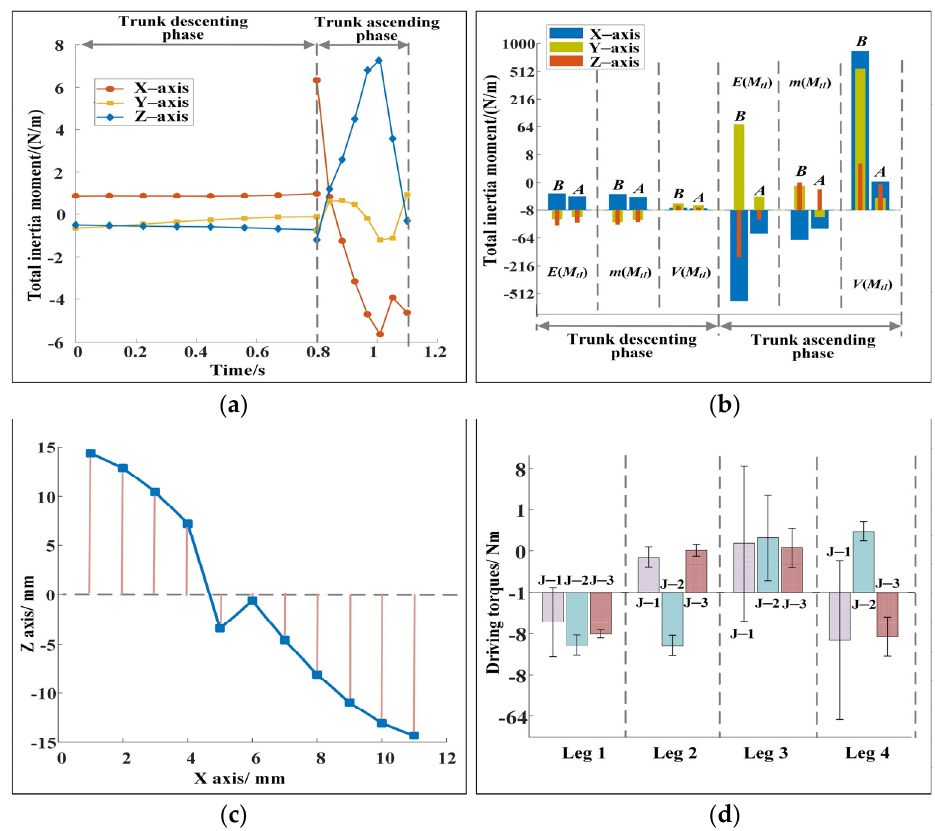
Figure 4. ( a ) Change of the total inertia moment of the robot in the descending and the ascending phases after optimization for example 1. ( b ) Changes of the total inertia moment of the robot before and after optimization for example 1. The maximum reduction of the end value, the mean, and the variance of the total inertia moment of the robot after optimization are 99.6%, 97.7%, and 99.9%, respectively, and the decreases are evident. ( c ) Change of ZMP during the descending phase of the trunk for example 1. ZMP changes near the connecting line of the landing points of two legs, showing good stability. ( d ) Mean and variance of the driving torques for example 1. The maximum difference of the mean value is 2.8 N·m, and the maximum variance is 7.16 N·m. The driving torques are within reasonable ranges.